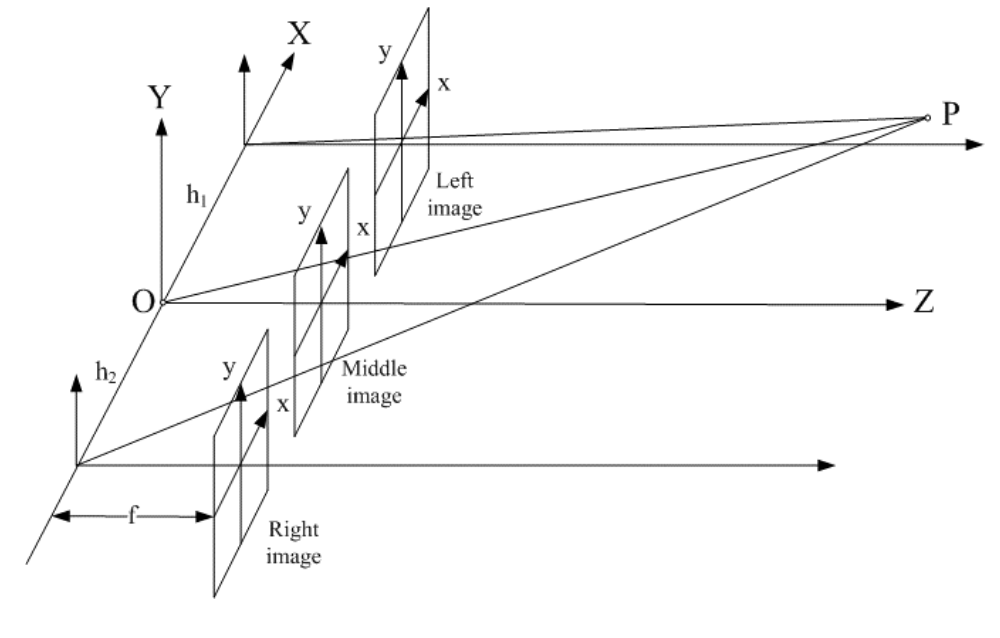
Figure 2. Schematic for the parallel